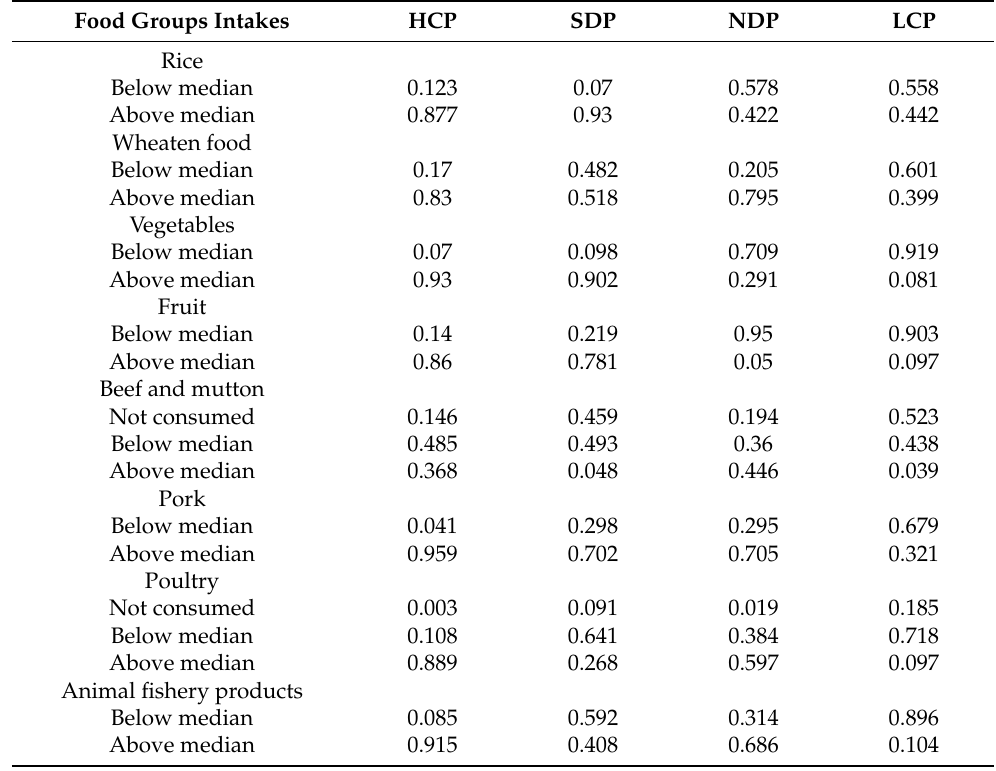
Table 4. Probabilities of the second-trimester food groups intakes derived from LCA,